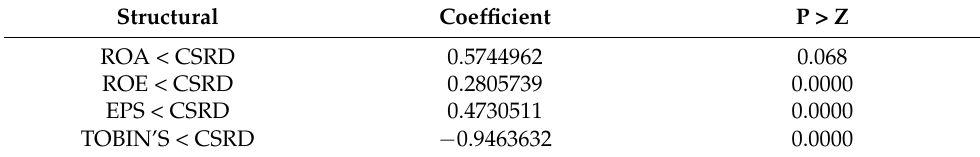
Figure 3. Result of corporate social responsibility disclosure and bank performance. Table 3. Result of corporate social responsibility disclosure and bank performance.